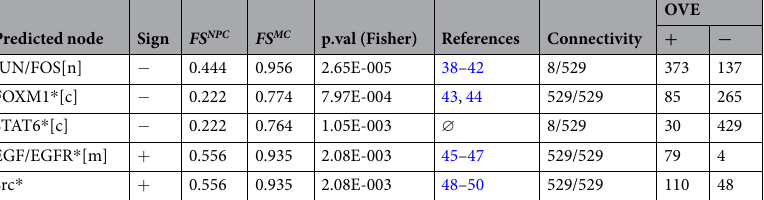
Table 2. 5 top-ranked results for the frequency analysis for MC signatures. FS NPC and FS MC show the frequency scores for NPC and MC, respectively. The references column lists the publications that agreed with our sign prediction. Connectivity refers to the ratio of genes connected to each predicted node. The OVE (observed variant expression) shows the repartition of variant gene expression using the best precision threshold without considering graph information.